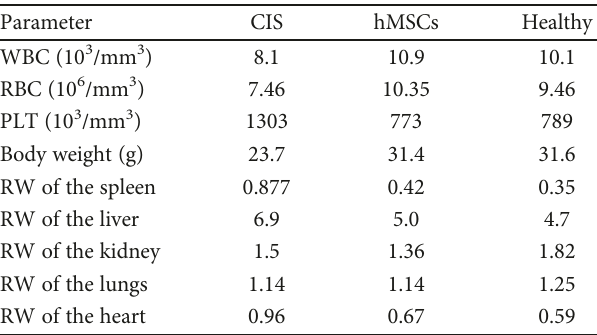
Table 5: Body weight, relative weight of organs, and blood parameters in BALB/cOlaHsd mice 3 months after hMSC